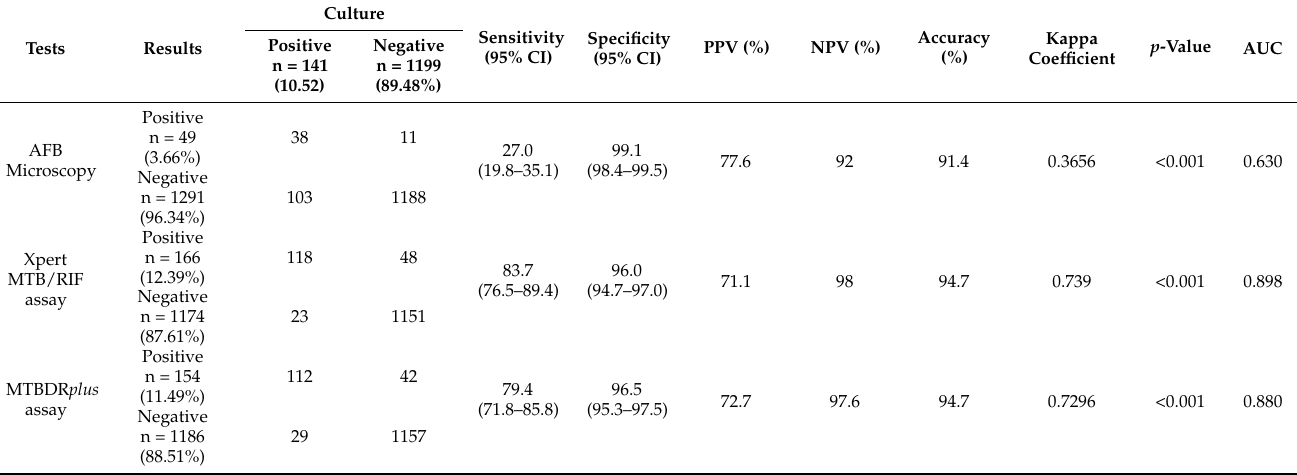
Table 1. Diagnostic performance of AFB microscopy, Xpert MTB/RIF t, and MTBDRplus for detection of EPTB cases compared to culture